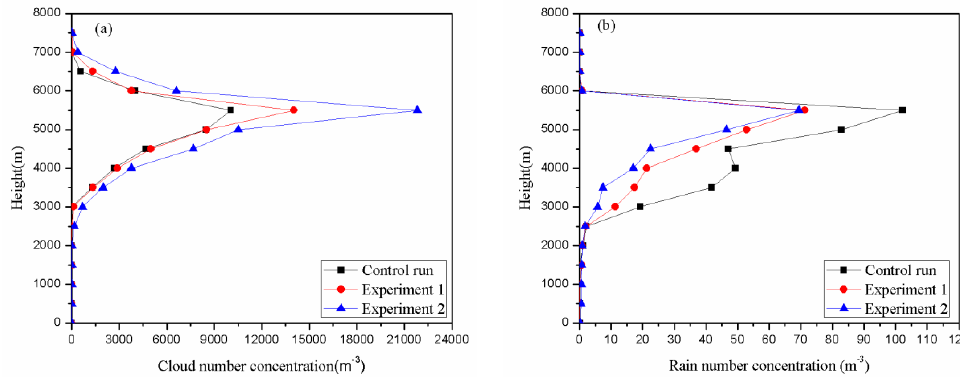
Figure 12. ( a ) Variation of Cloud number concentration on 22 March 2008 with vertical height, ( b ) Variation of Rain number concentration on 16 August 2008 with vertical height .